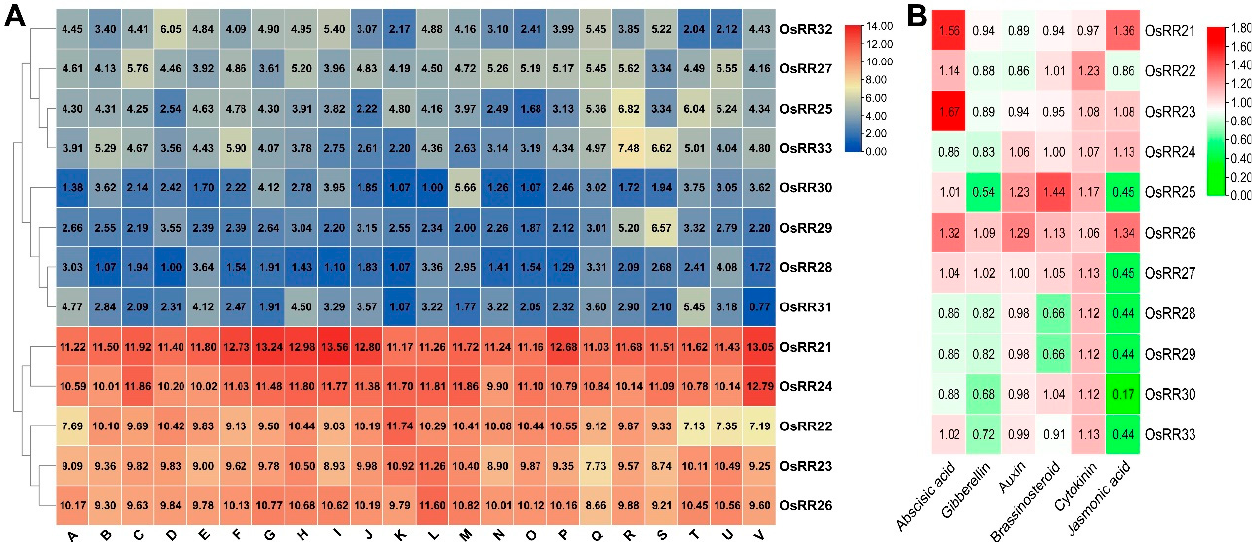
Figure 3. Expression pattern analysis of type-B OsRRs in rice. ( A ). Expression pattern analysis of type-B OsRRs throughout the growth period (A: germinating seed harvested at 72 h post imbibition. B: Light and dark grown plumules harvested at 48 h after germination. C: Light and dark grown radicles harvested at 48 h after germination (radicle 1, radicle 2). D: Three-day-old seedling. E: Shoot of seedlings with three two tillers. F: Roots of seedlings with three tillers. G: Leaf tissues from plants with panicles shorter than 1 mm. H: Sheath tissues from plants with panicles shorter than 1 mm. I: Leaf tissues from plants with panicles between 40 and 50 mm. J: Sheath tissues from plants with panicles between 40 and 50 mm. K: Panicle (40 to 50 mm). L: Stem tissue at 5 d before flowering. M: Leaf tissues at 5 d before heading. N: Stem tissue at the heading stage, O: Panicle at the heading stage. P: Palea/lemma at 1 d before flowering. Q: Stamen at 1 d before flowering. R: Spikelet at 3 d post anthesis. S: Endosperm at 7 d post anthesis. T: Endosperm at 14 d post anthesis. U: Endosperm 21 d post anthesis. V: Flag leaf at 14 d post anthesis). ( B ). Expression pattern analysis of rice type-B OsRRs in response to different hormone treatment.